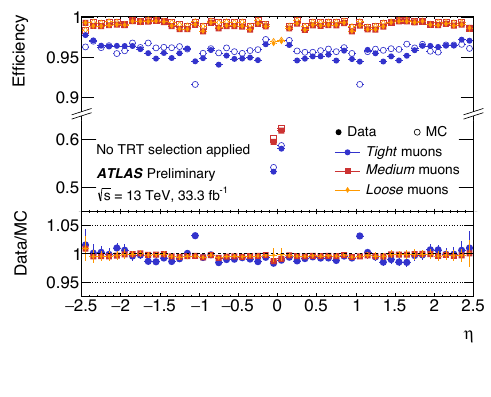
Figure 2. Muon reconstruction e ffi ciencies for the Medium identification algorithm measured in µµ and Z µµ events as a function of the J /ψ → → muon momentum. The prediction by the detector simulation is depicted as empty circles (squares), while the full circles (squares) indicate the observation in collision data. Only statistical errors are shown in the top panel. The bottom panel reports the e ffi ciency scale factors. The darker error bands indicate the statistical uncertainty, while the lighter bands indicate the sum of the statistical and systematic uncertainties in quadrature. Figure from